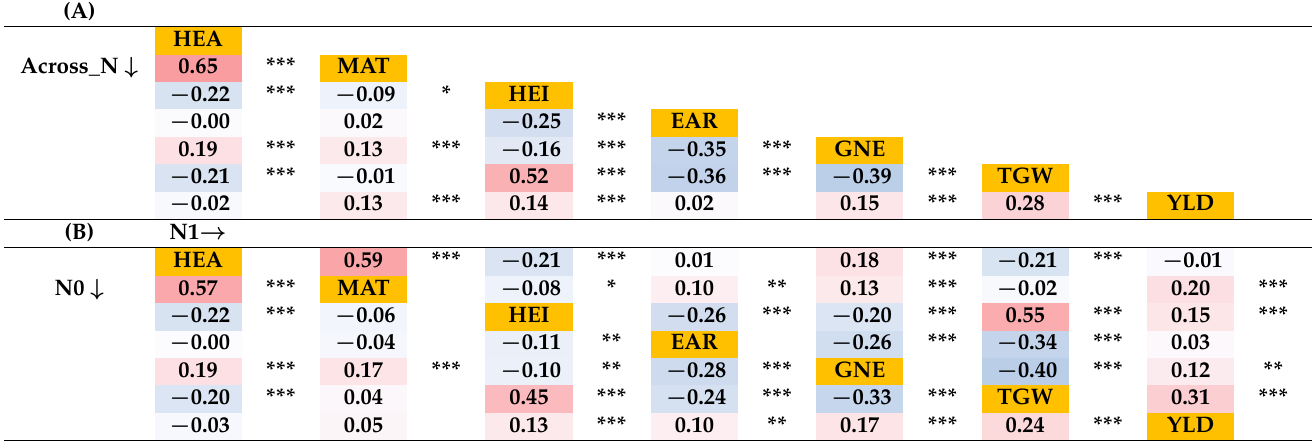
Table 2. Pearson correlations between seven traits studied in WM-800. ( A ) Correlation coefficients (r) based on LSMEANS calculated across both N treatments. ( B ) Correlation coefficients (r) based on LSMEANS calculated under N0 (lower triangle) and N1 (upper triangle) treatments. Trait abbrevia- tions are given in the diagonal boxes and explained in Table 5. Significant correlations are indicated by asterisks with *: p < 0.05, **: p < 0.01 and ***: p < 0.001. Colors correspond to the strength of the correlation on a scale from − 1 (blue) to +1 (red).